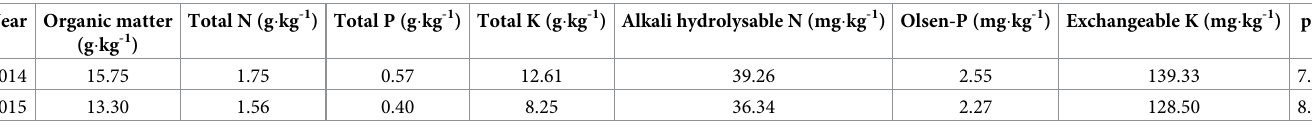
Table 1. Properties of the tested soil in the experiment sites in 2014–2015. Year Organic matter (g � kg -1